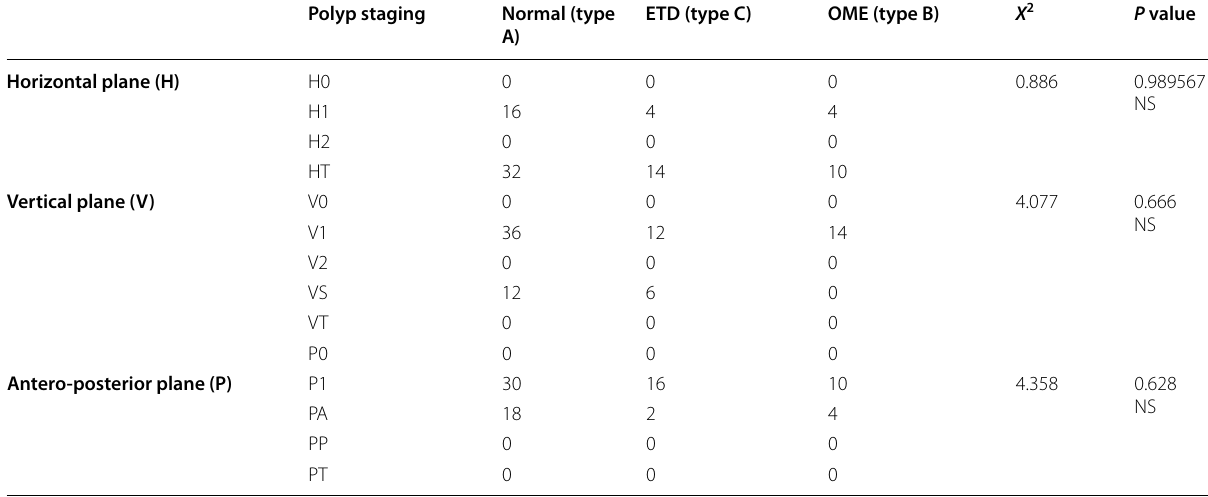
Table 2 Tympanometric results in different nasal polyposis